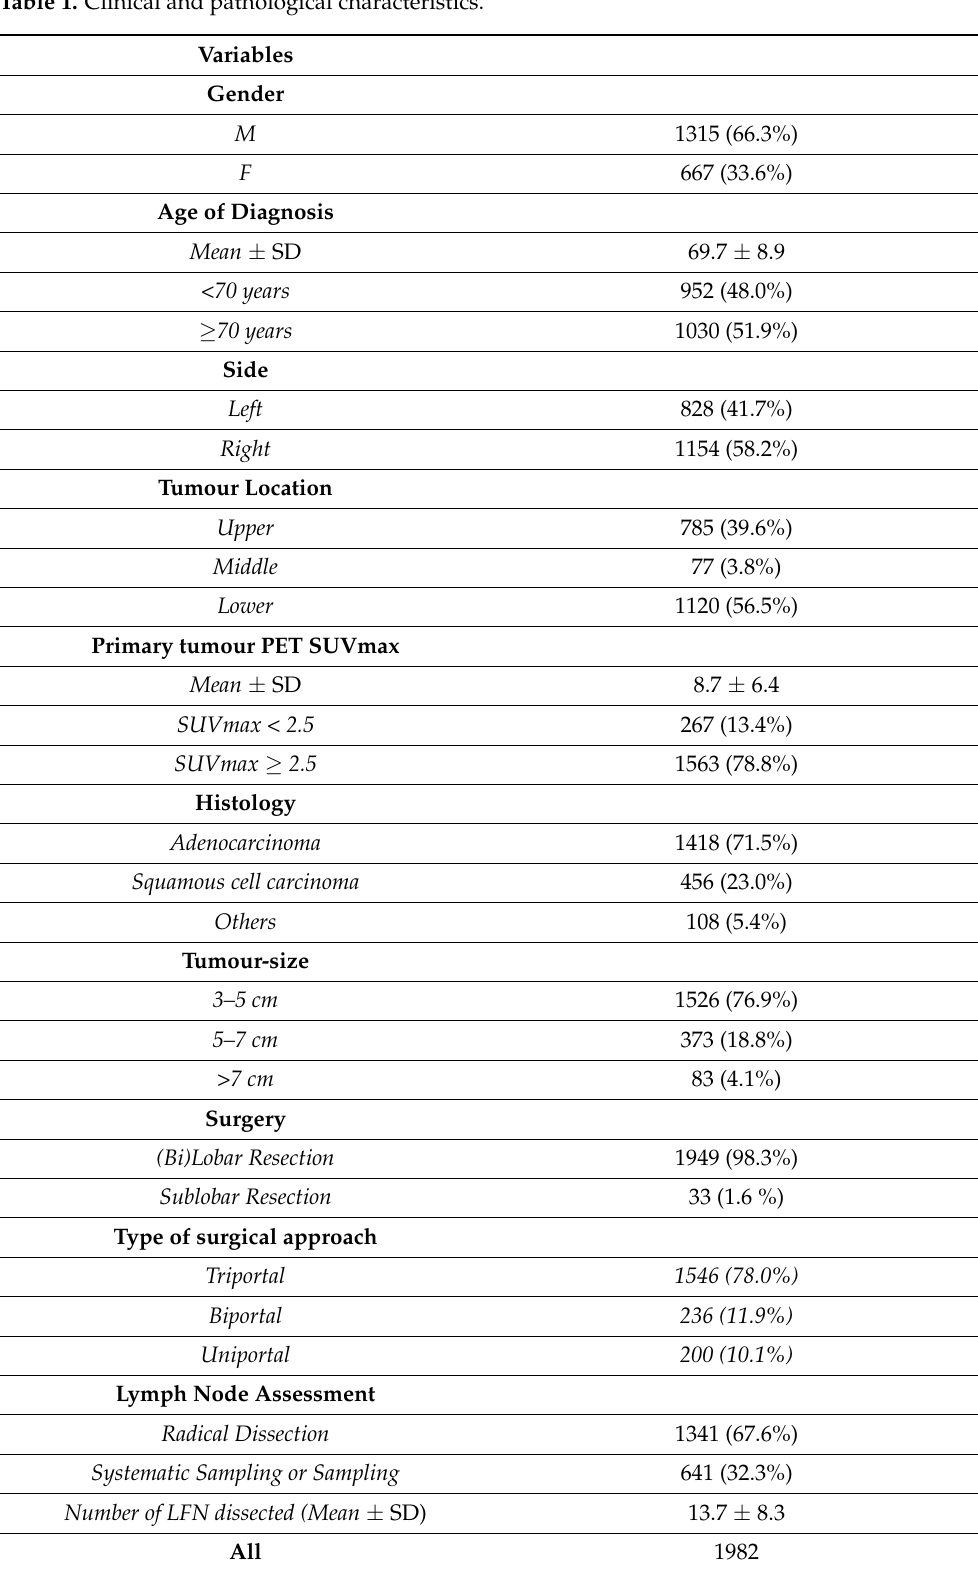
Table 1. Clinical and pathological